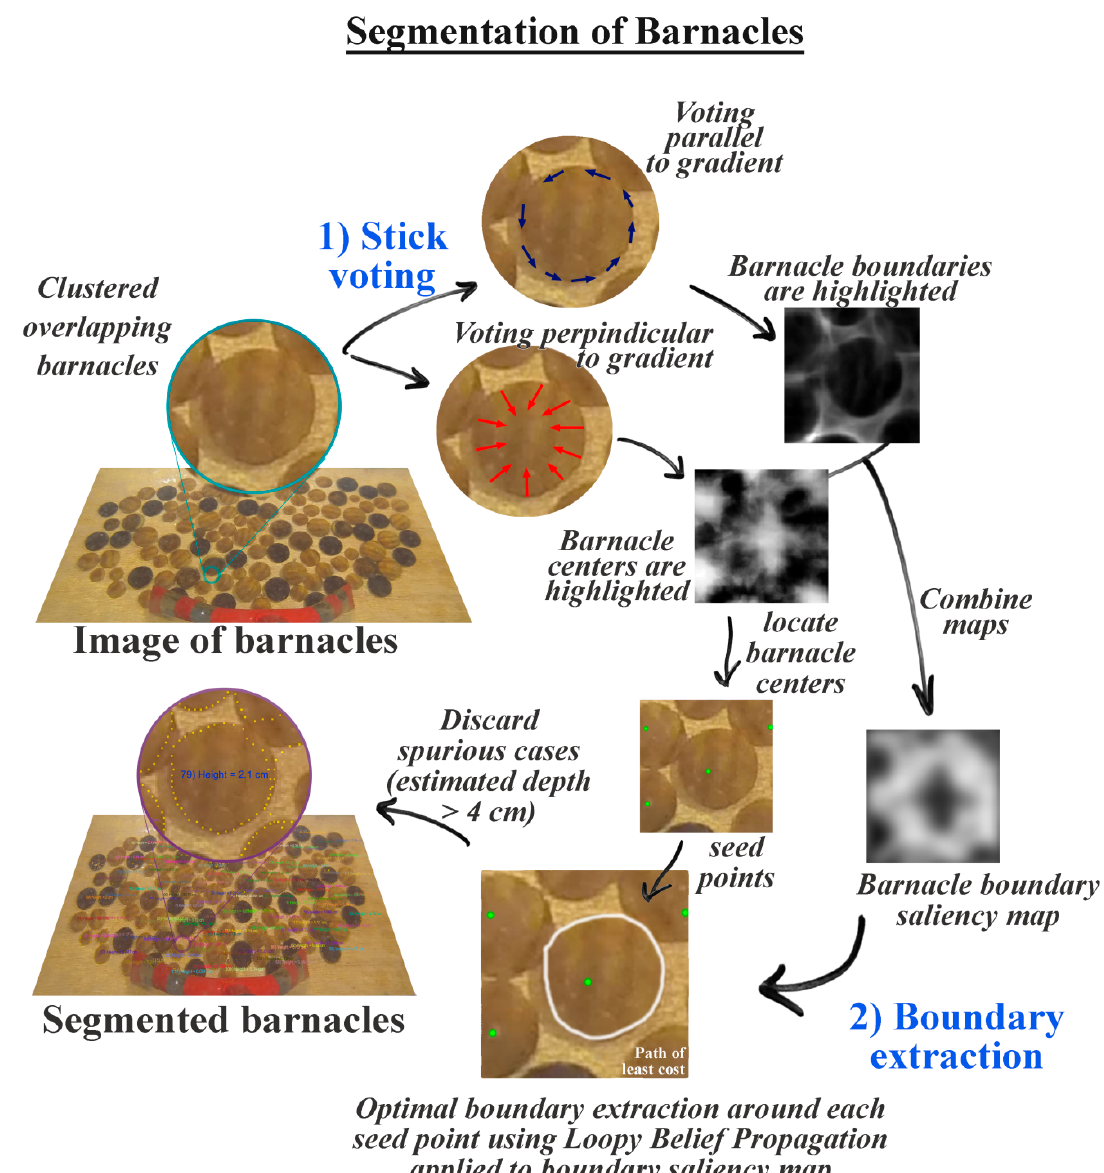
Figure 8. Automatic specimen segmentation technique schematic.